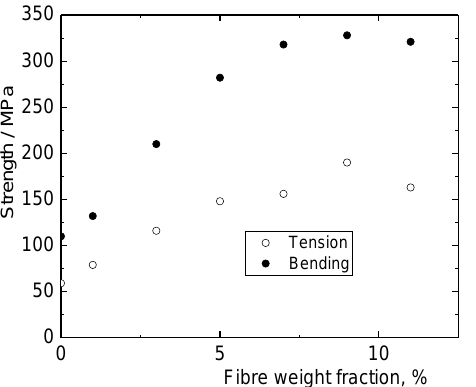
Figure 9. Tensile and bending strength of carbon-fibre/aluminium-matrix composites with short fibres coated with copper. After experimental data published in [33].